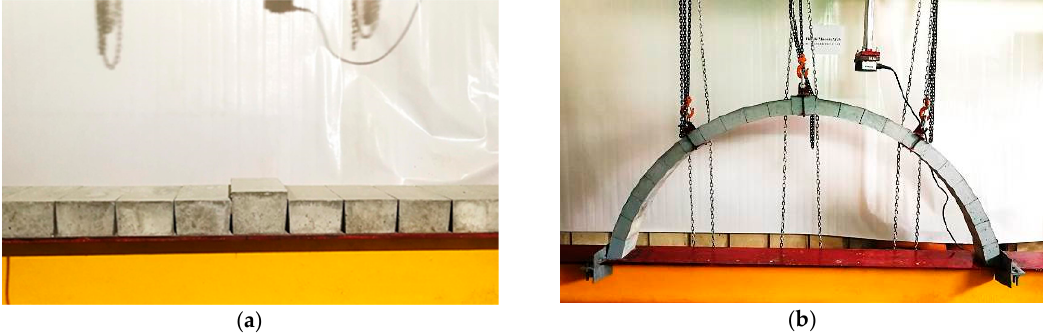
Figure 6. Placing voussoirs on the rigid bed ( a ), erecting self-form arch with thicker Keystone ( b ).